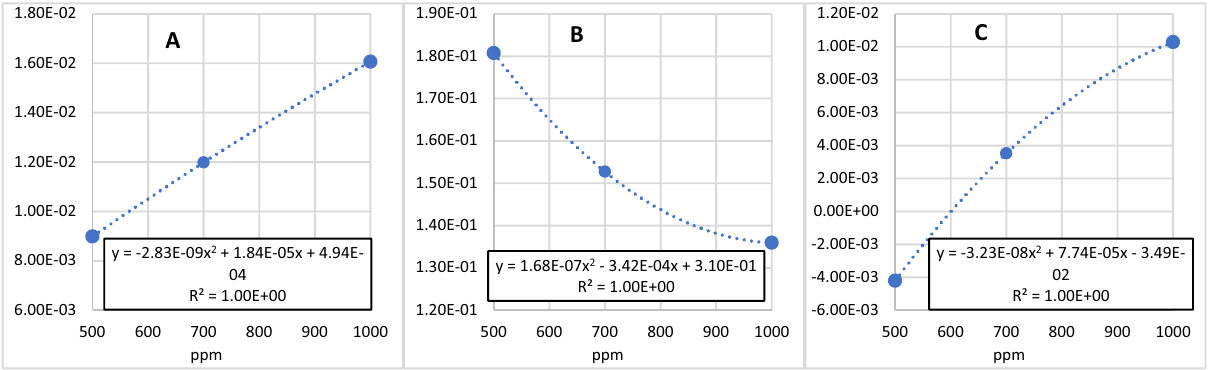
y = -2.83E-09x 2 + 1.84E-05x + 4.94E- 04 R² = 1.00E+00